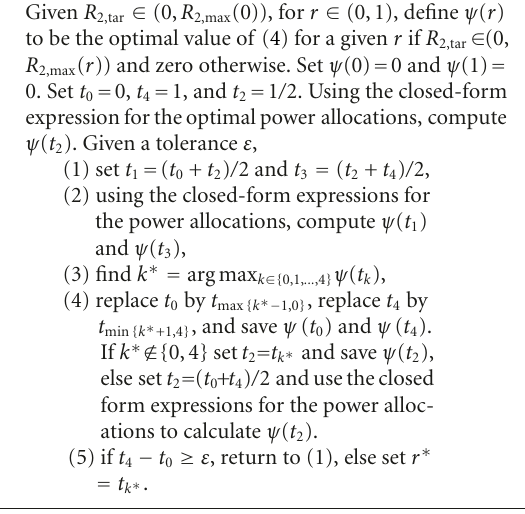
Algorithm 1: A simple method for finding r